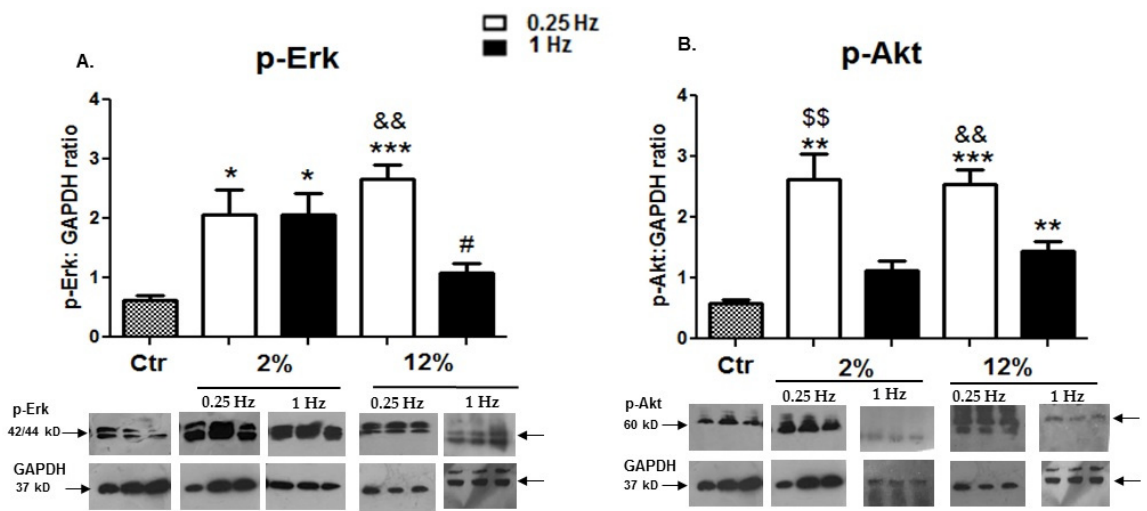
Figure 7. ( A , B ) Effects of cyclic mechanical stretching on the activation of the signalling proteins Akt and Erk1/2. Representative Western blots and immunoblotting quantification of ( A ) p-Erk1/2 and ( B ) p-Akt phosphorylation in cardiomyoblasts subjected to different mechanical loading protocols compared to the control (Ctr; nonstretched myotubes). The values of the phosphorylated proteins were normalized to each corresponding GAPDH on the same immunoblot. The same blots have been used for GAPDH in Figure 3D,E, in Figure 5C, and in Figure 7A,B except for the blot of GAPDH in ( A ) for the 2%/1 Hz stretching protocol. Significantly different compared to the control * p < 0.05; ** p < 0.01; *** p < 0.001. Significantly different compared to the 2%/0.25 Hz stretching protocol, # p < 0.05. Significantly different compared to the 2%/1 Hz stretching protocol, $$ p < 0.01. Significantly different compared to the 12%/1 Hz stretching protocol, && p < 0.01. Mean + SE of three independent experiments performed in triplicate.